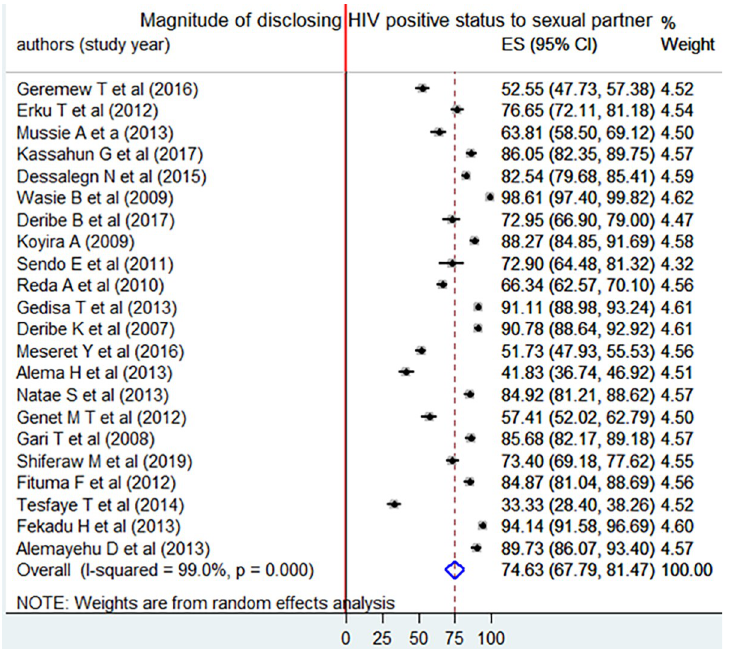
Fig 2. Forest plot of the pooled magnitude of disclosing HIV status to sexual partner using the random effect model, a systematic review and meta-analysis, Ethiopia, 2020.